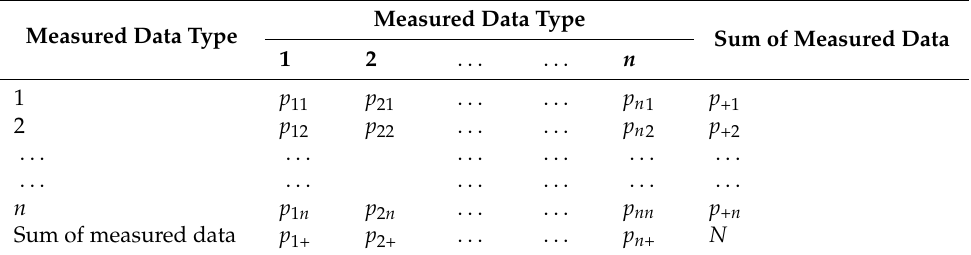
Table 4. Confusion matrix [27].